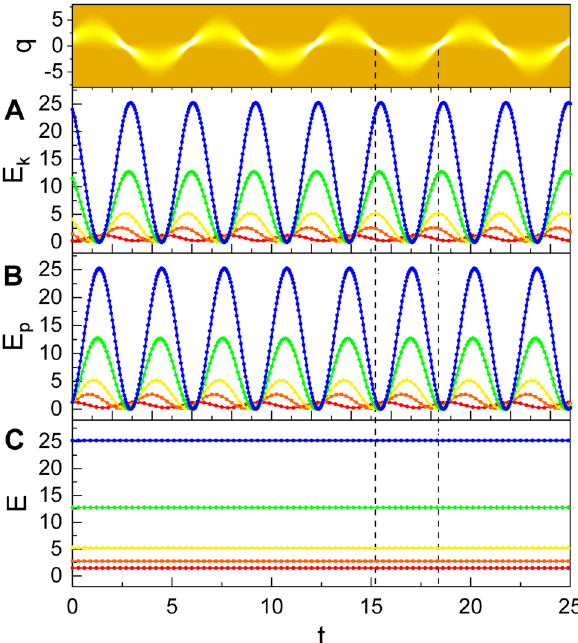
Figure 3. Time evolution of quantum electric energy E k , quantum magnetic energy E p , and total quantum energy E for several different values of c 1 . The value of c 1 that we have chosen is 1 for red, 2 for orange, 4 for yellow, 10 for green, and 20 for blue lines. We have used c 2 ϕ θ 0 . The evolution of the probability density for the case of c 1 = = associated to the quantities of yellow